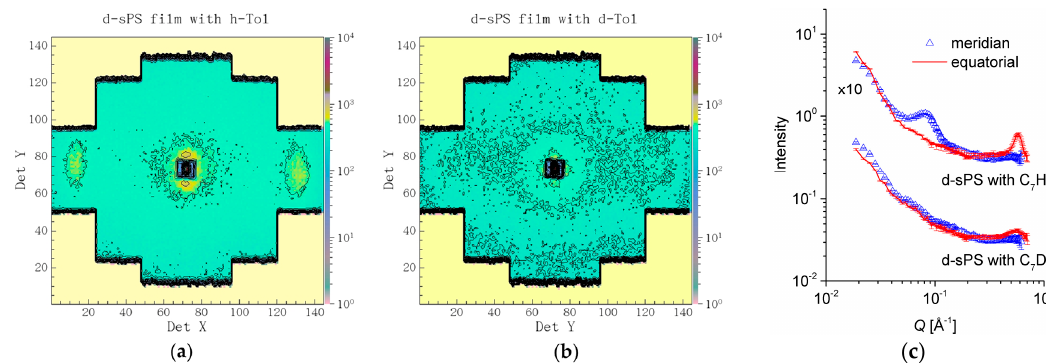
Figure 4. Two-dimensional SANS patterns from a deuterated sPS film clathrated with protonated toluene ( a ) or deuterated toluene ( b ), respectively, and the one-dimensional scattering profiles from the same samples averaged over the equatorial (line) or meridian (symbol) directions, respectively ( c ). The panels ( a , b ) show data collected at L D = 2 m, while the experimental curves in panel ( c ) were obtained by merging data collected at L D = 2 and 4 m.